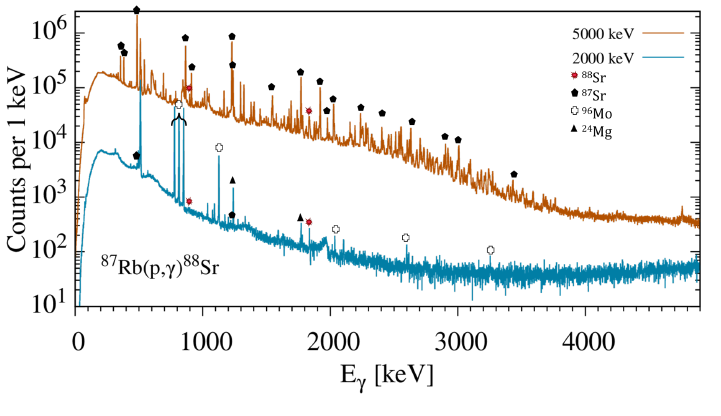
Figure 2. Comparison of γ -ray spectra obtained at beam energies of E p = 2000keV and 5000keV. The di ff erent symbols represent the di ff erent origins of the peaks.